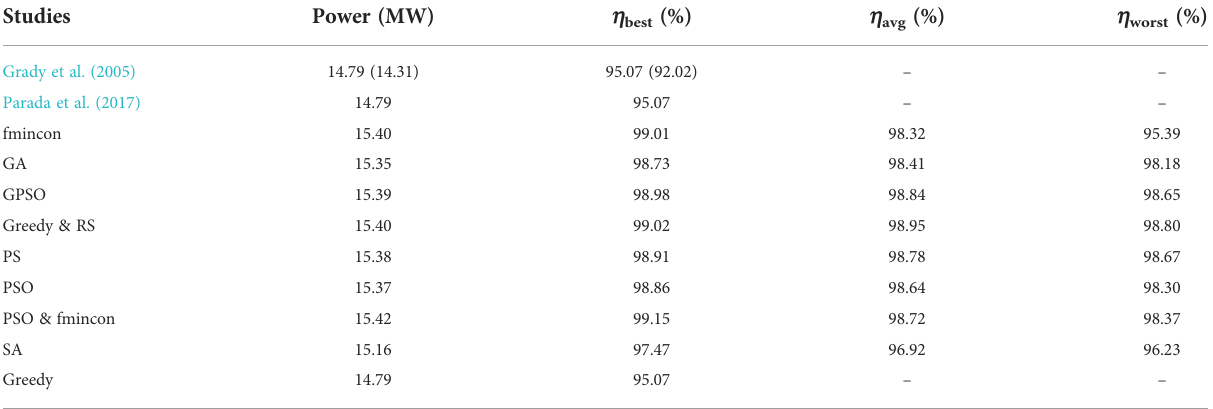
TABLE 2 Comparison of global best solutions of different